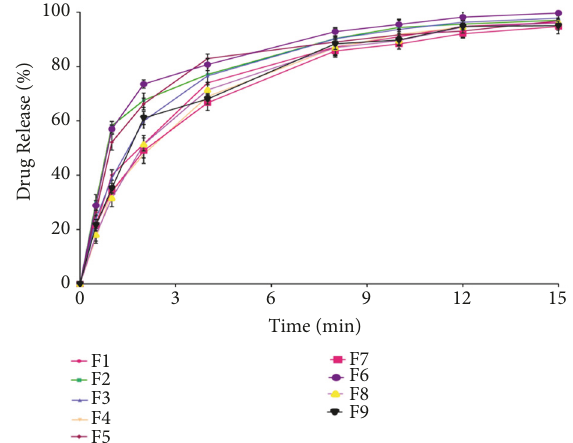
Figure 5: In vitro drug dissolution study of fast dissolving films formulations F1 to F9